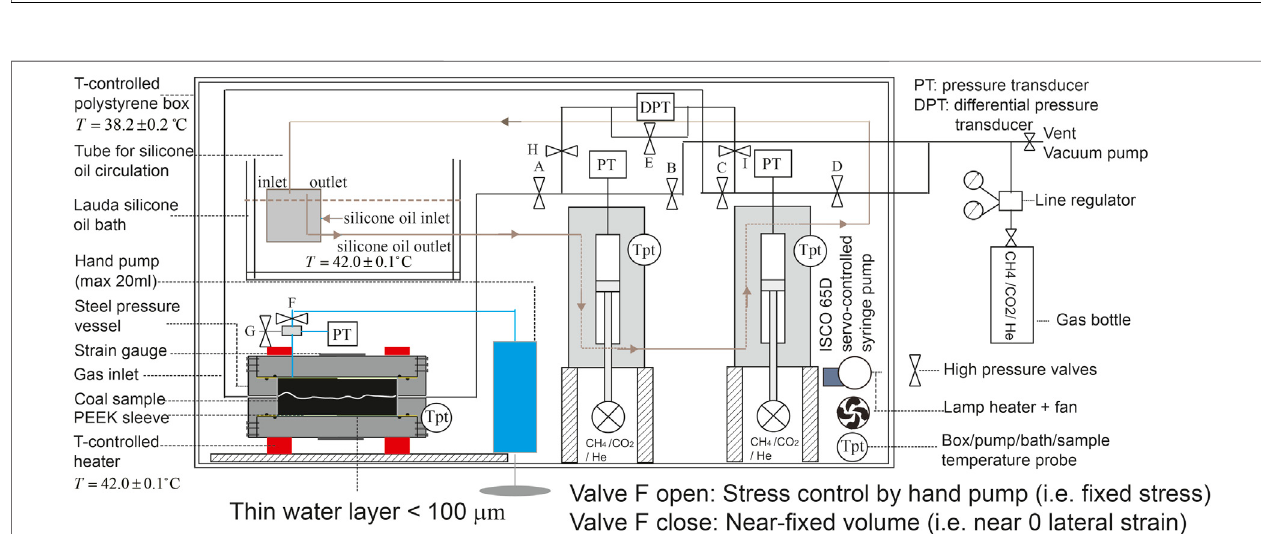
FIGURE 2 | Schematic illustration of the complete experimental setup. The cylindrical sample, sleeved by a PEEK jacket, is located inside the cylindrical steel pressure vessel. The vessel, wrapped in two electrical heaters at 42.0 ± 0.1 ° C, is connected to two ISCO 65D syringe pumps used for permeability measurements to CH 4 /CO 2 /He. Note that a thin water layer between the PEEK sleeve and the steel vessel supports a con fi ning pressure. The valve F is used for controlling boundary conditions employed to the sample. The con fi ning pressure applied to the sample is measured by the pressure transducer and is controlled by a hand pump. The pressuredifferencebetweentwoISCOpumpsismeasured byadifferentialpressuretransducer(DPT).ThetemperatureoftheISCOpumpsiscontrolledat42.0±0.1 ° C by using Lauda silicone oil bath. An internally heated foam – polystyrene box is constructed around the syringe pumps, hand pump, oil bath, and permeability vessel to control the air temperature around the full setup at 38.2 ± 0.2 °